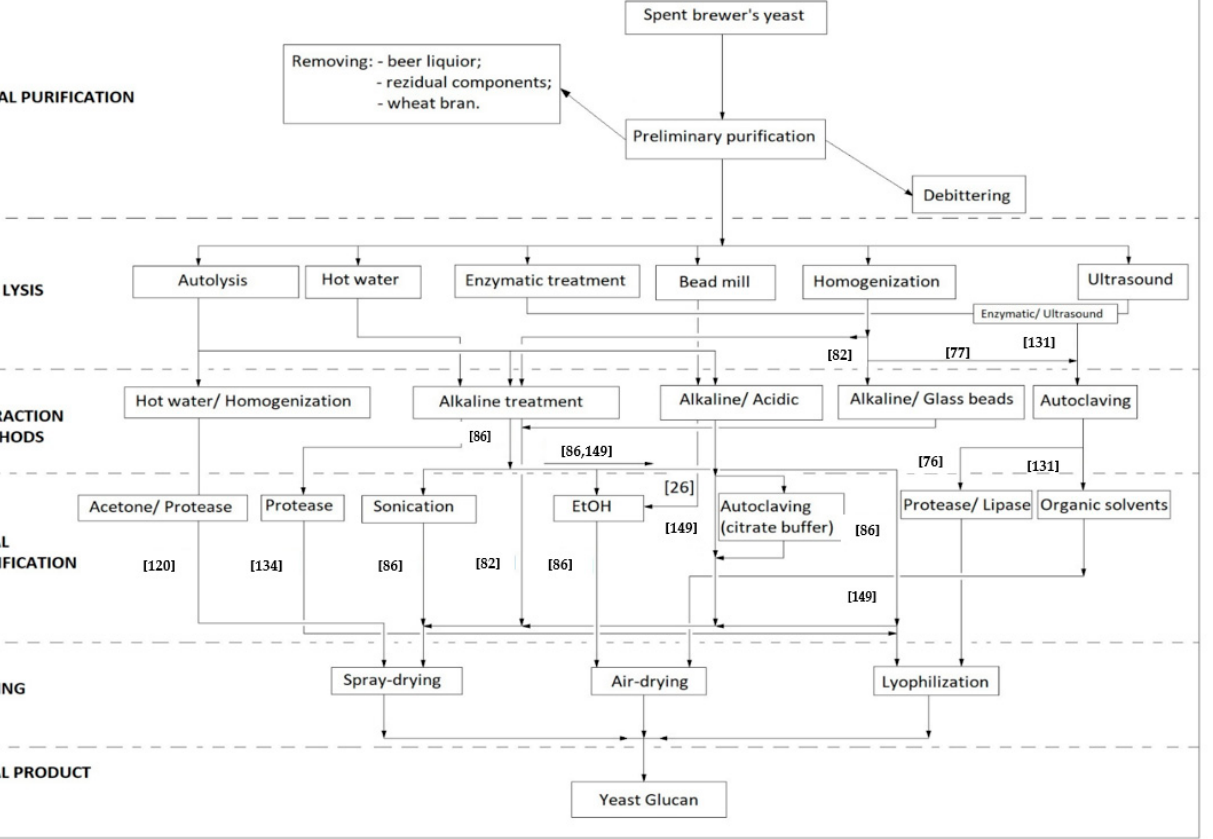
Figure 4. Protocols for obtaining β -glucans from spent brewer’s yeast.